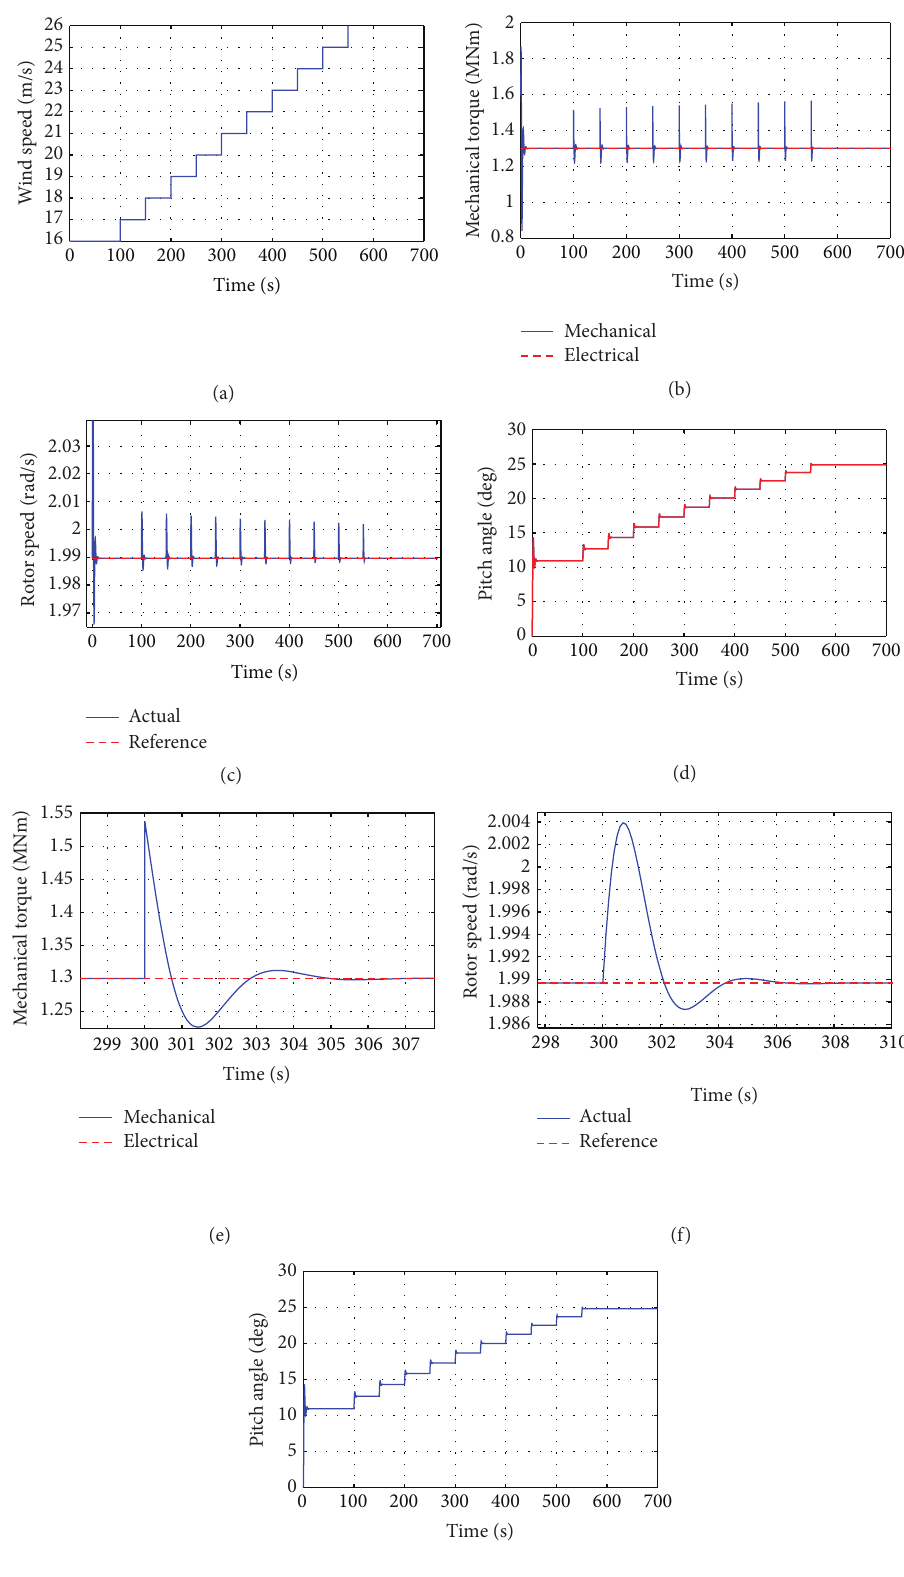
Figure 9: Step response of the pitch regulated WT system under ideal grid conditions: (a) wind speed, (b) output torque, (c) rotor speed, (d) pitch angle for the whole high speed region and (e) output torque, (f) rotor speed, and (g) pitch angle for one wind